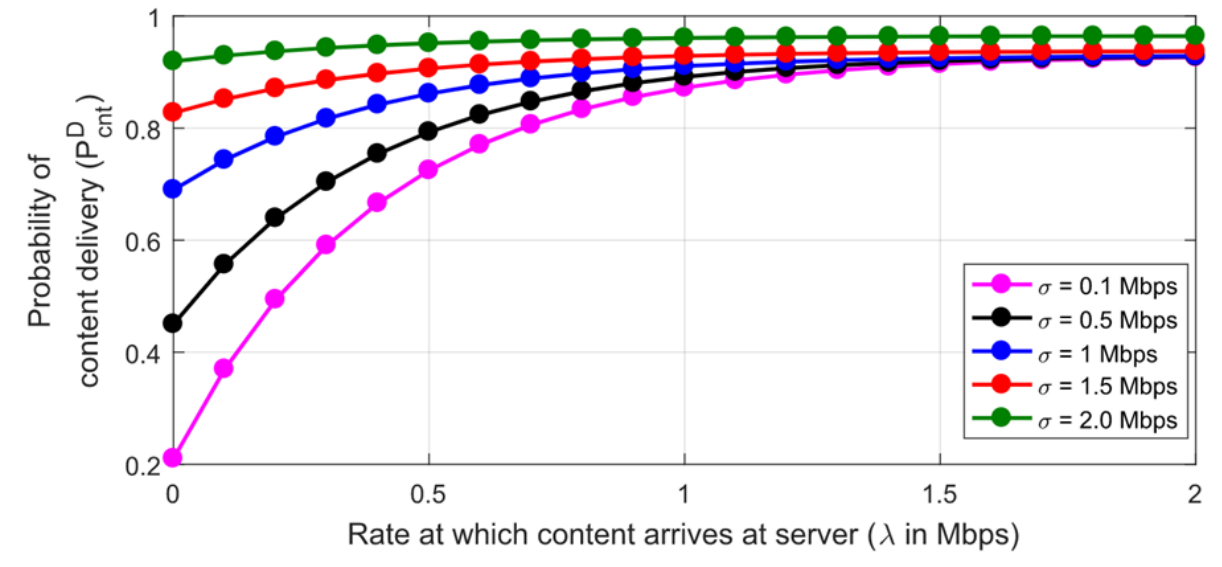
Figure 9. Effect of content arrival rate on probability of content delivery for n = 1.